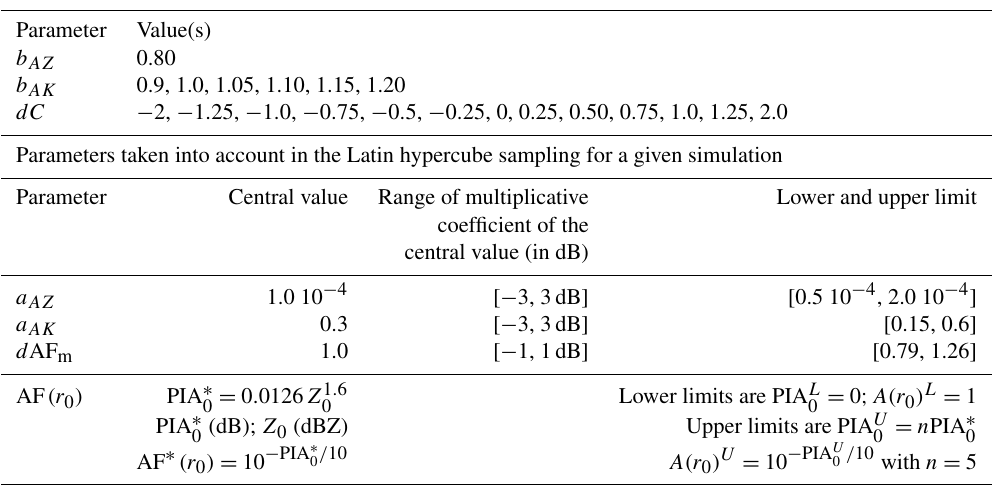
Table 1. Values and ranges of the variation in the attenuation model parameters in the sensitivity analysis. Parameters fixed for a given